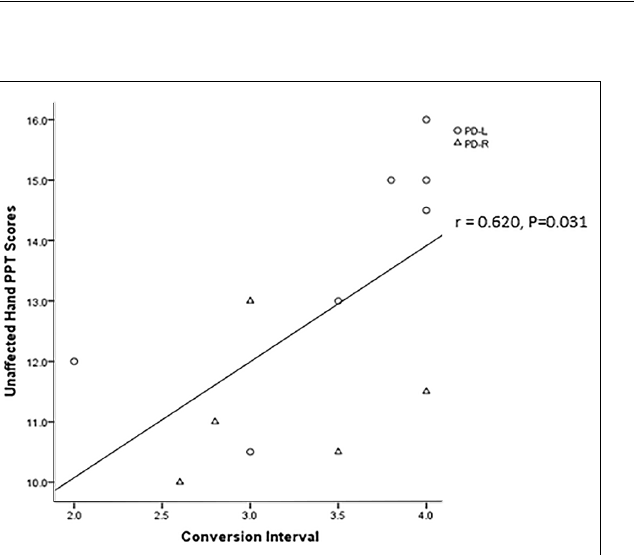
FIGURE 2 | The correlation between the patients’ asymptomatic hands baseline PPT scores and their unilateral affected to bilateral affected conversion